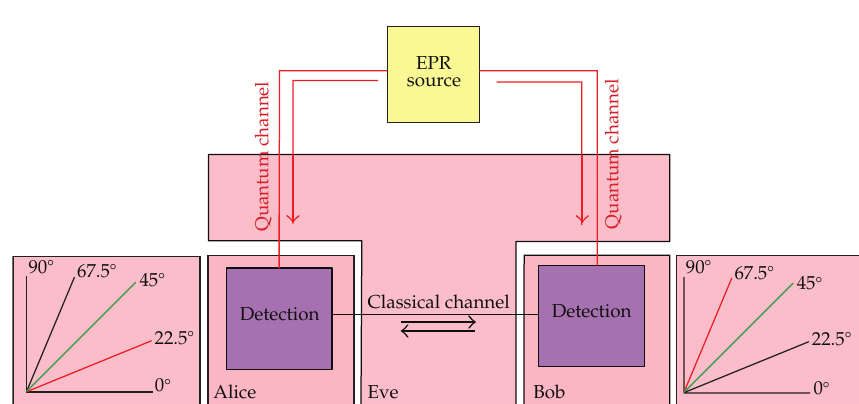
Figure 1: Scheme of the Ek91